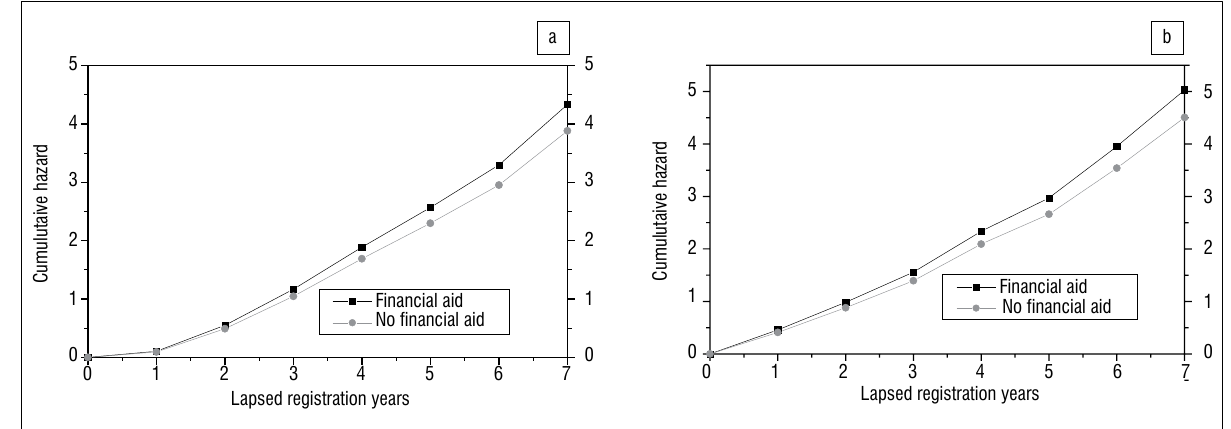
Figure 6: Cumulative hazard functions by financial aid for master’s students who (a) graduated or (b) dropped out of study at the University of